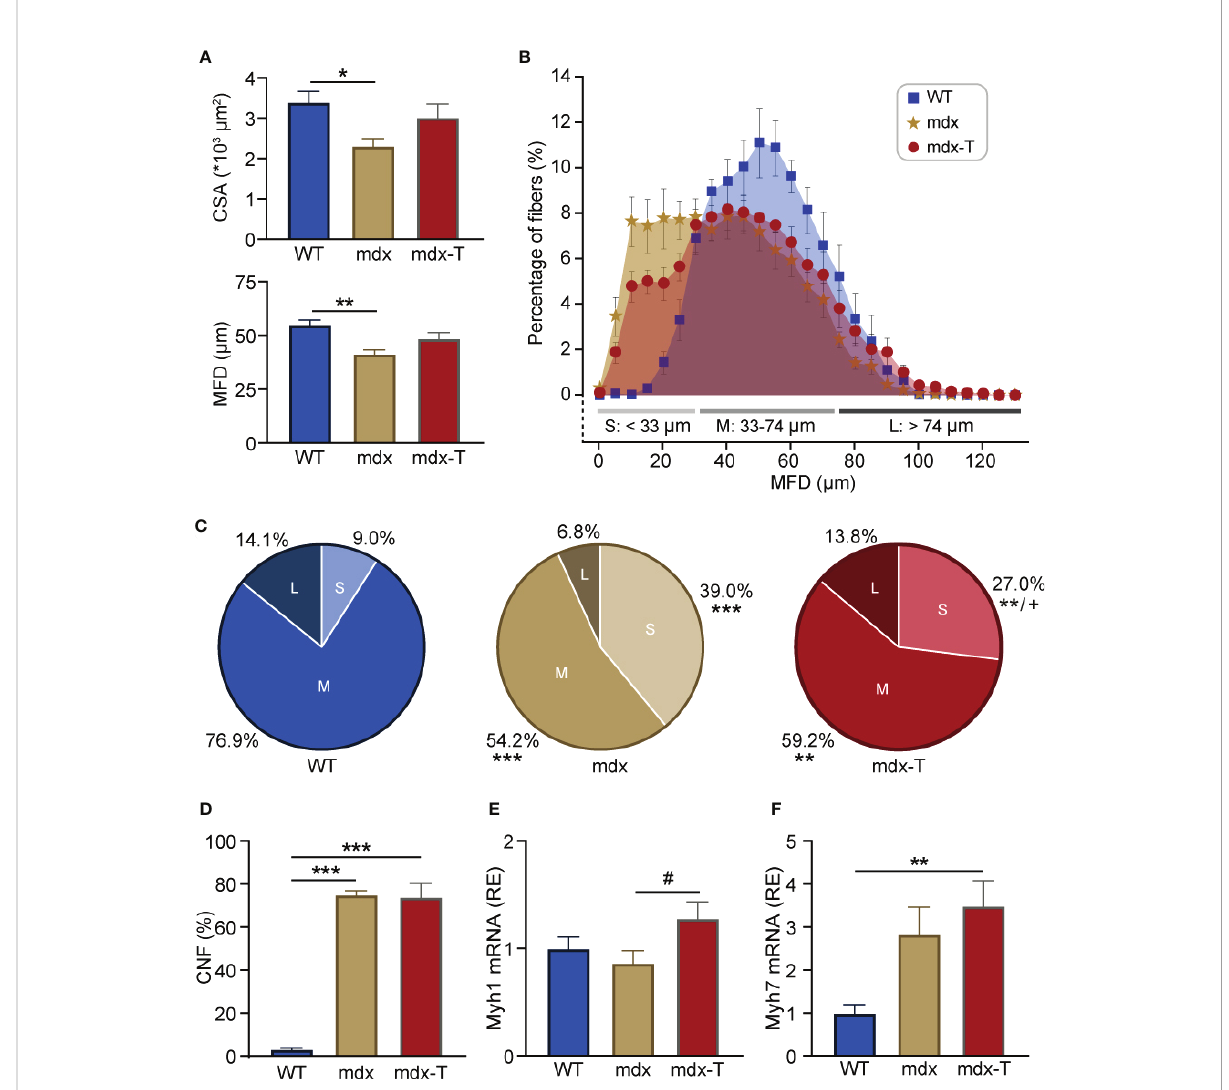
FIGURE 4 MCC950 treatment enhances muscle fi bre size and maturation in mdx mice. (A) Quanti fi cation of global fi bre size based on cross-sectional area (CSA) or minimum Feret ’ s diameter (MFD) in Q sections from the 3 groups of mice. (B) Overall distribution of fi bre MFD. Data are expressed as percentage of myo fi bres in bins of 5 μm each. Fibres were classi fi ed into three categories based on their size [small (S), medium (M) or large (L)]. (C) Pie chart representing the percentage of small (pale), middle-sized (regular) and large myo fi bres (dark) for each group. (D) Quanti fi cation of the percentage of central nucleated fi bres (CNF) per fi eld. (E, F) mRNA levels of Myh1 and Myh7, markers of glycolytic and oxidative muscle fi bres, respectively. These levels were normalized to cyclophilin A, and subsequent ratios were presented as relative expression compared to WT values. Data are means ± SEM; n = 6 mice per group for all experiments. Statistical analysis was performed using one-way ANOVA followed by Tukey ’ s test (A- F) * P < 0.05, ** P < 0.01, *** P < 0.001, + P < 0.05 (comparison between small fi bres from mdx and mdx-t mice) (C) , # P = 0.08 (E)